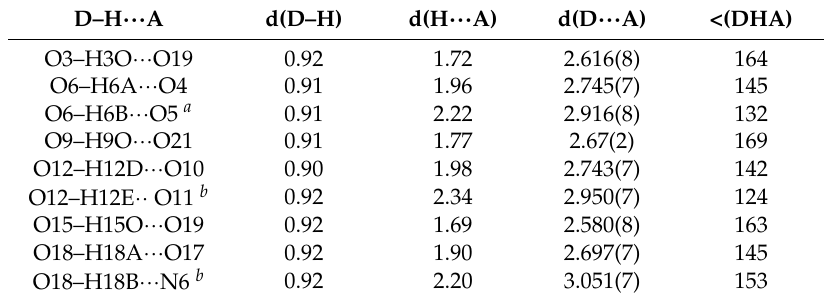
Figure 9. Crystal packing of 3-Ni along the crystallographic c axis. Table 3. Hydrogen bonds for 3-Ni [Å and °].